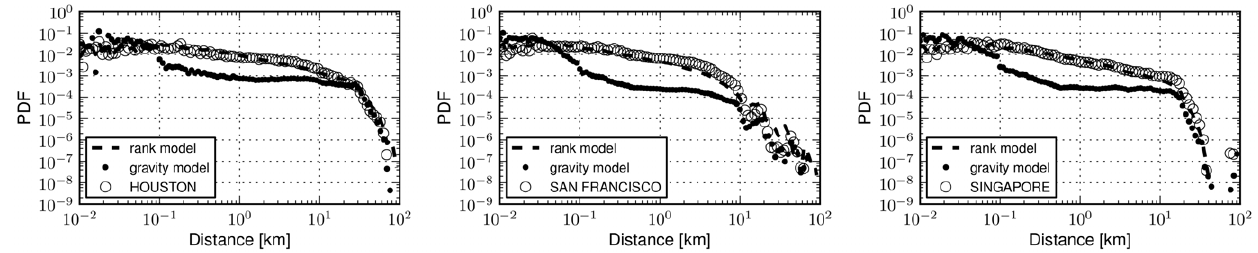
Figure 8. Fitting urban movements. Probability Density Functions (PDF) of human movements and corresponding fits with the rank-distance and gravity models in three cities (Houston, San Francisco and Singapore). In the rank-distance model the probability of transiting from a place u to a place v in a city, only depends on the rank value of v with respect to u . In the case of the gravity model, the deterrence affect of distance is co- integrated with a mass based attractiveness of a place u . The associated mass, m u , has been defined according to the number of neighboring places. The parameters for the depicted fit of the gravity model are b ~ 1 : 0 and r u ~ 100 meters. The places of a city employed for the simulation experiments where those observed in the Foursquare dataset, hence while the rank-based model is the same for all cities the underlying spatial distribution of places may vary. Excellent fits are observed for all cities analyzed. It is interesting to note that the model is able to reproduce even minor anomalies, such as the case of San Francisco where we have ‘jumps’ in the probability of a movement at 20 and 40